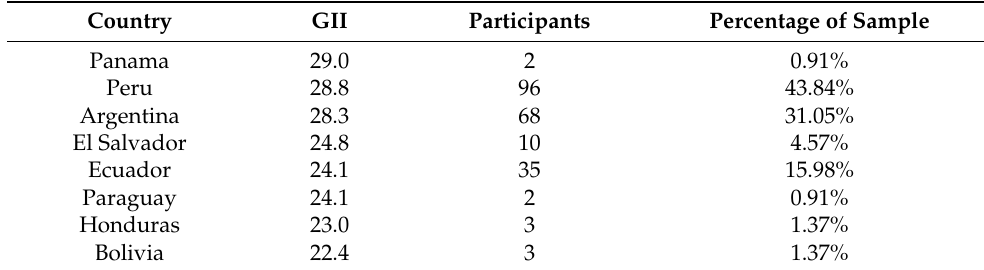
Table 1. Number of participants by country, ordered by GII. Country GII Participants Percentage of